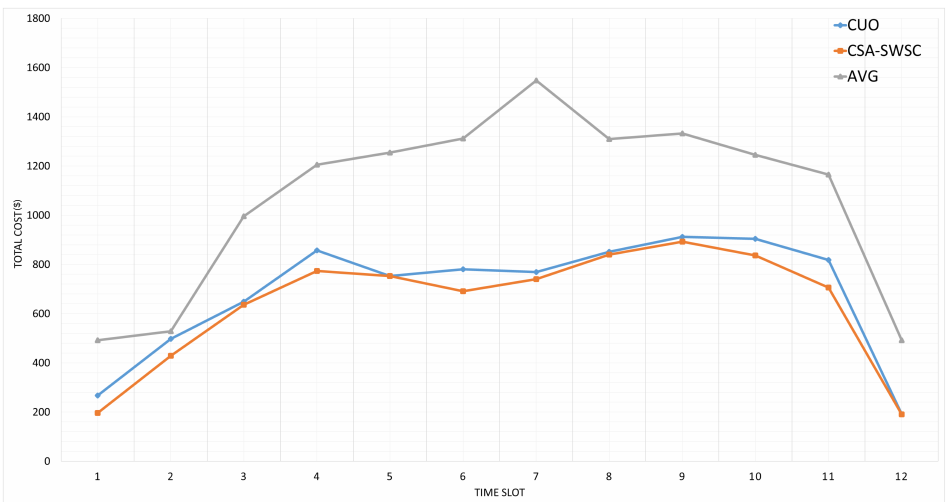
Figure 5. Total cost of buyers.